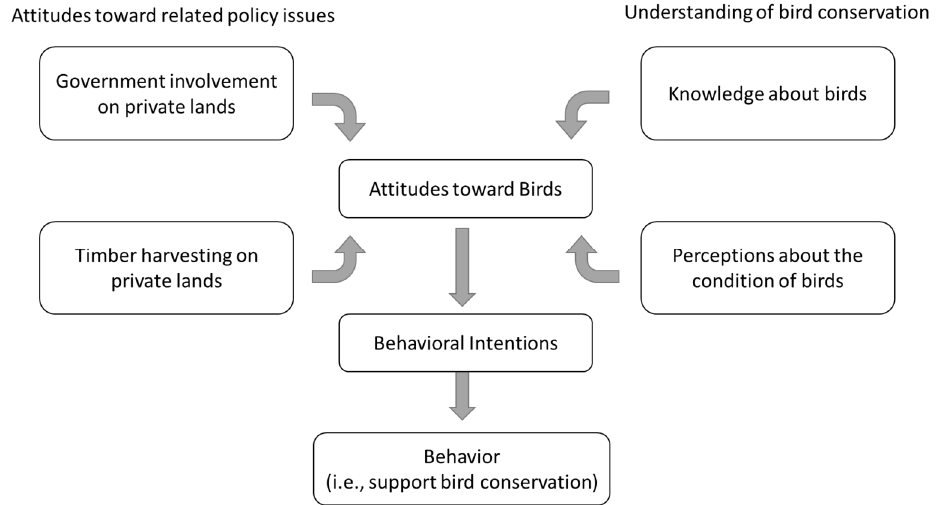
Figure 1. Conceptual model of the relationship between attitudes towards birds, knowledge and perceptions and attitudes toward decisions that impact private lands.